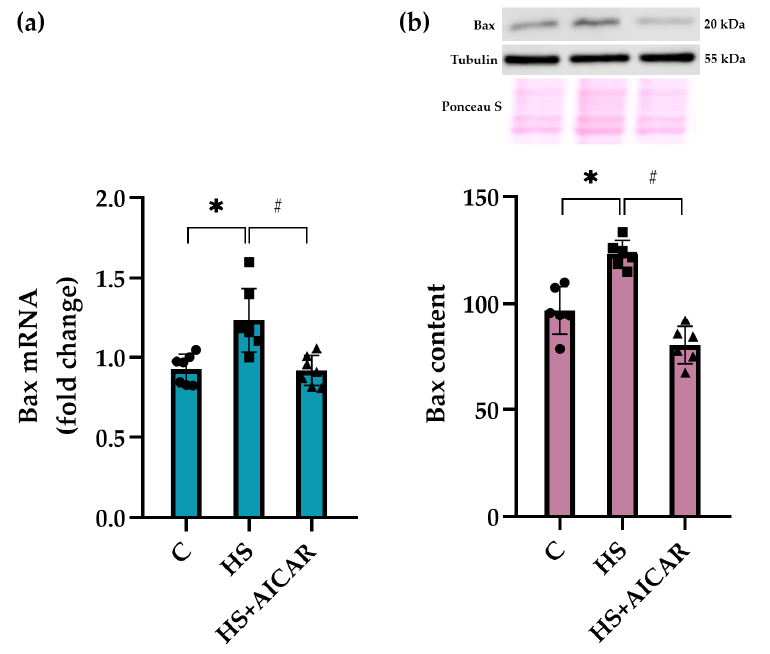
Figure 5. Effect of AICAR treatment on ( a ) Bax mRNA expression and ( b ) Bax protein content in differentiating myoblasts derived from the atrophied rat soleus muscle. C—myoblasts derived from rat soleus muscle of the control rats, HS—myoblasts derived from rat soleus muscle after 7-day HS, HS+AICAR—myoblasts derived from rat soleus muscle after 7-day HS and treated with AICAR. Values are means ± SEM, expressed as fold changes vs. C (PCR data, n = 7) or as % of C (WB data, n = 6). Dots, squares and triangles on the bars represent individual data points. *— p < 0.05 vs. C; #— p < 0.05 vs.